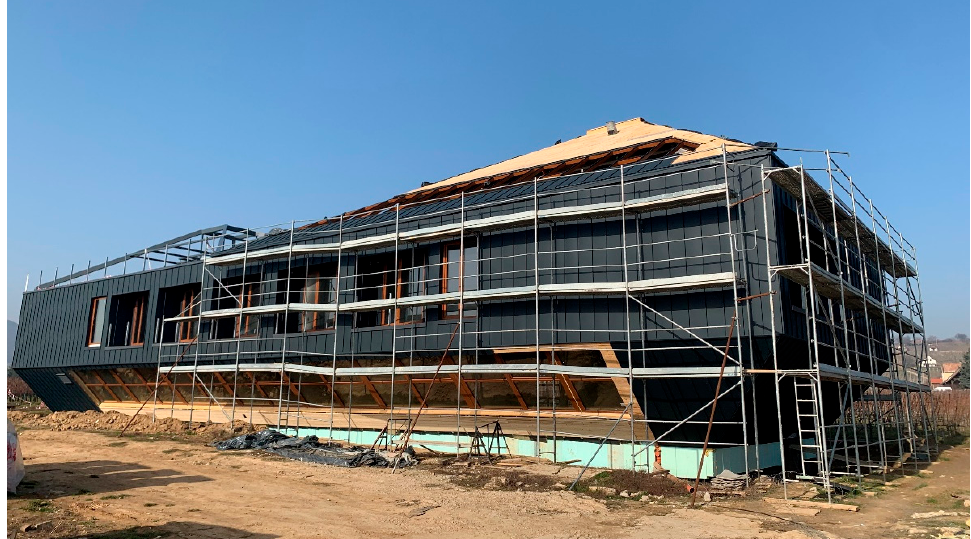
Figure 1. The prototype building under construction with the wind catcher inlet (left pyramid) and the ‘Venturi’ outlet structures (right pyramid).